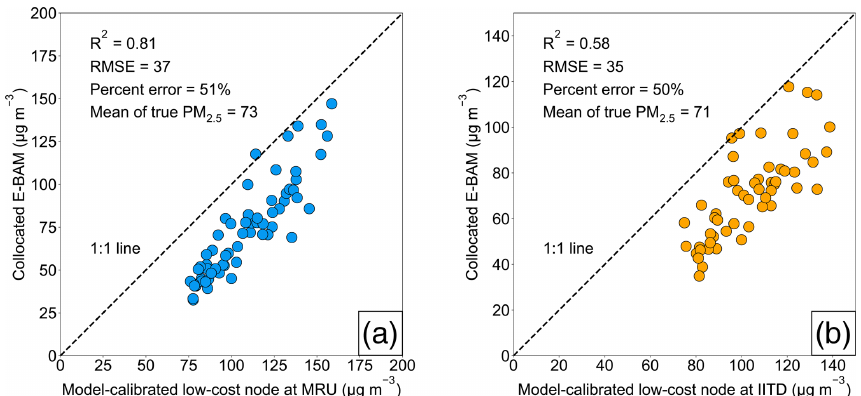
Figure 7. Correlation plots comparing the GPR model-calibrated low-cost node PM 2 . 5 mass concentrations to the collocated E-BAM mea- surements at (a) MRU and (b) IITD sites. In both (a) and (b) , correlation of determination ( R 2 ), RMSE, percent error, and mean of the true ambient PM 2 . 5 mass concentrations throughout the study (from 1 January to 31 March 2018) are superimposed on the correlation